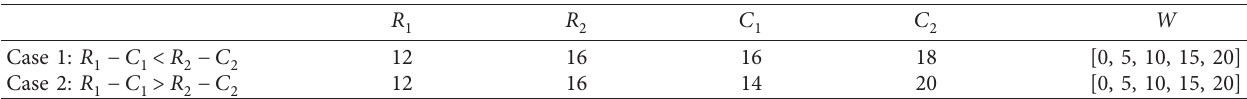
Table 7: Parameter setting of situation